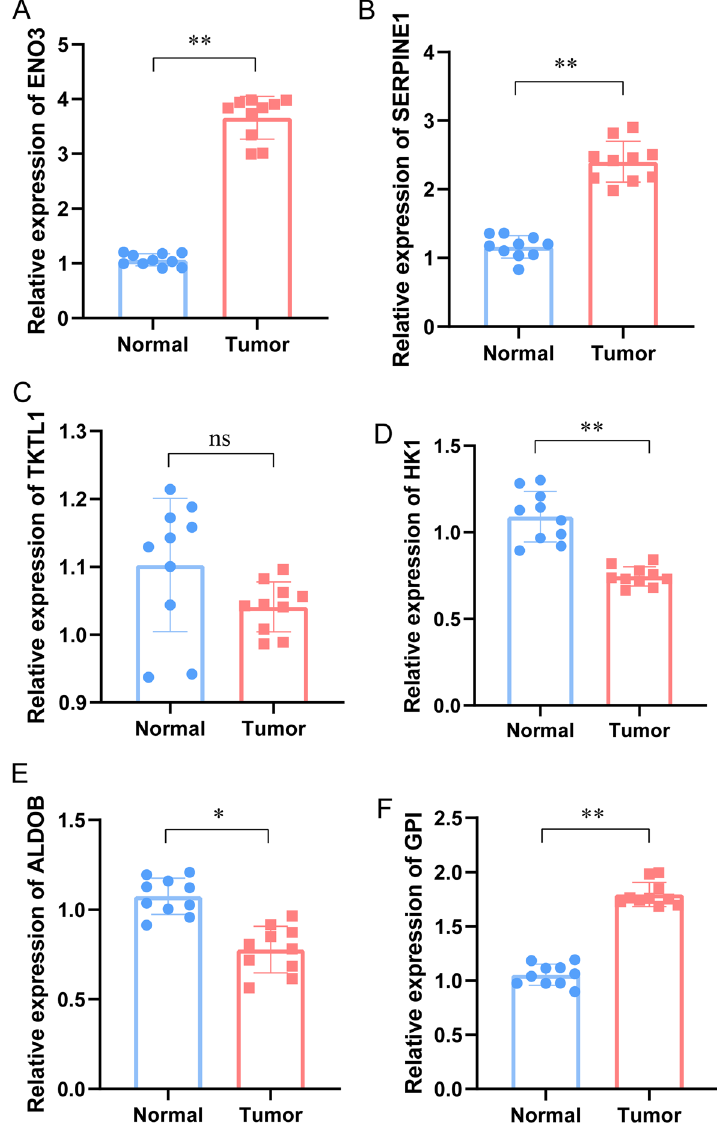
Figure 7. Expression of the signature’s six HRGs in normal and CRC tissues. The mRNA expression of ( A ) ENO3 , ( B ) SERPINE1 , ( C ) TKTL1 , ( D ) HK1 , ( E) ALDOB , and ( F ) GPI . Key: *, P < 0.05; **, P <